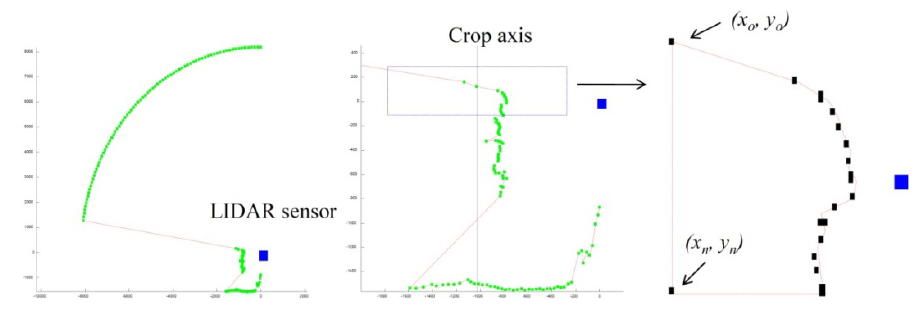
Figure 5. From impact points measured on the crop canopy (left) the average distance to the crop axis is calculated (middle) as crop width. Crop area is also determined for every individual height (right) from the Cartesian coordinates of every single